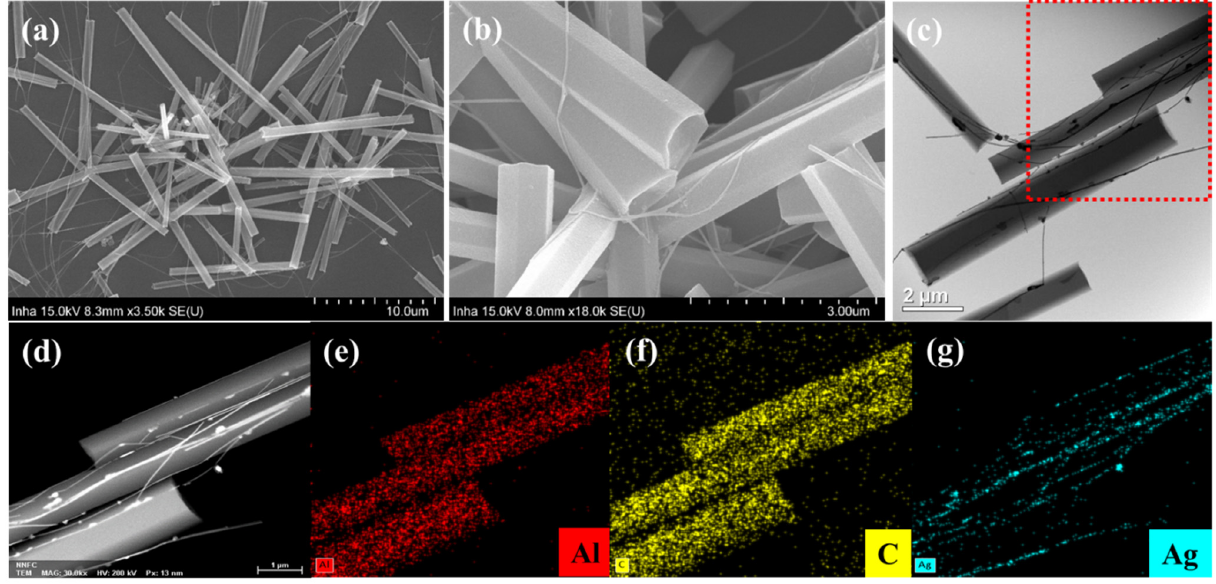
Figure 2. ( a , b ) show SEM images of the hybrid Alq 3 /Ag NWs-MRs. ( c ) HR-TEM image of a single hybrid Alq 3 /Ag NWs-MR. ( d – g ) EDX mapping images in the red dashed box of ( c ), exhibiting Al ( e ), C ( f ), and Ag ( g ), respectively.